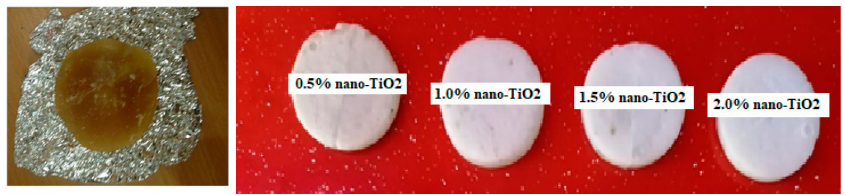
Figure 3. Samples of paraffin and nano-paraffins used in the study.